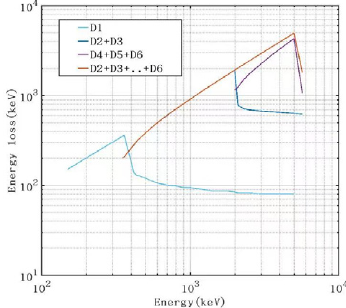
Figure 10. Energy loss curves of electrons in semiconductor sensors. sensor was output to the pre-amplifier circuit independently. Finally, the six channel front- shaped signals were combined into three channel outputs after the main amplifier. The specific combination method was that the first sensor (D1) had a single channel signal A1, the second and third sensors (D2 and D3) were combined into one channel signal A2, and the remaining three sensors (D4, D5, and D6) were combined into one channel signal A3. According to the above simulation results and logical working principle, the working mode of high-energy electron detection can be determined, as shown in Table